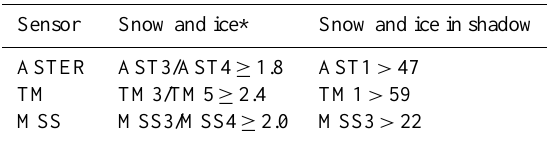
Table 2. Thresholds used for glacier mapping for all investigated Sensors. Sensor Snow and ice* Snow and ice in